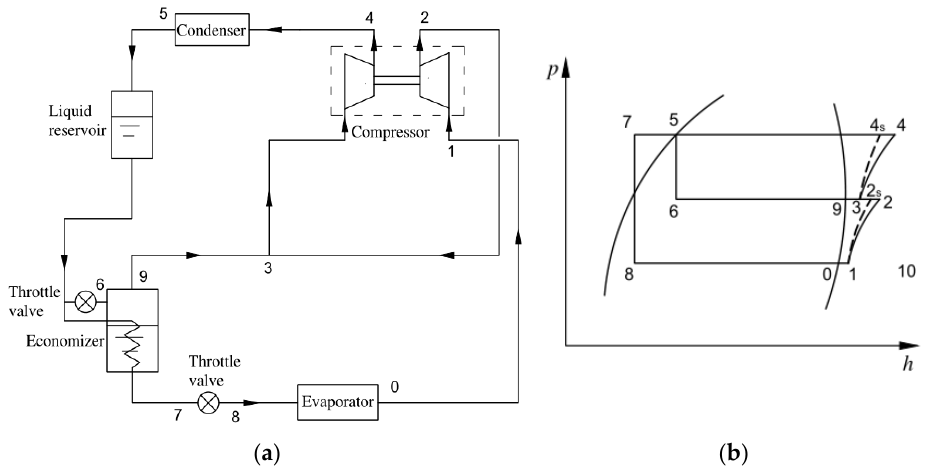
Figure 2. Schematic and pressure-diagrams of refrigeration system: ( a ) Schematic; ( b ) Pressure-enthalpy.